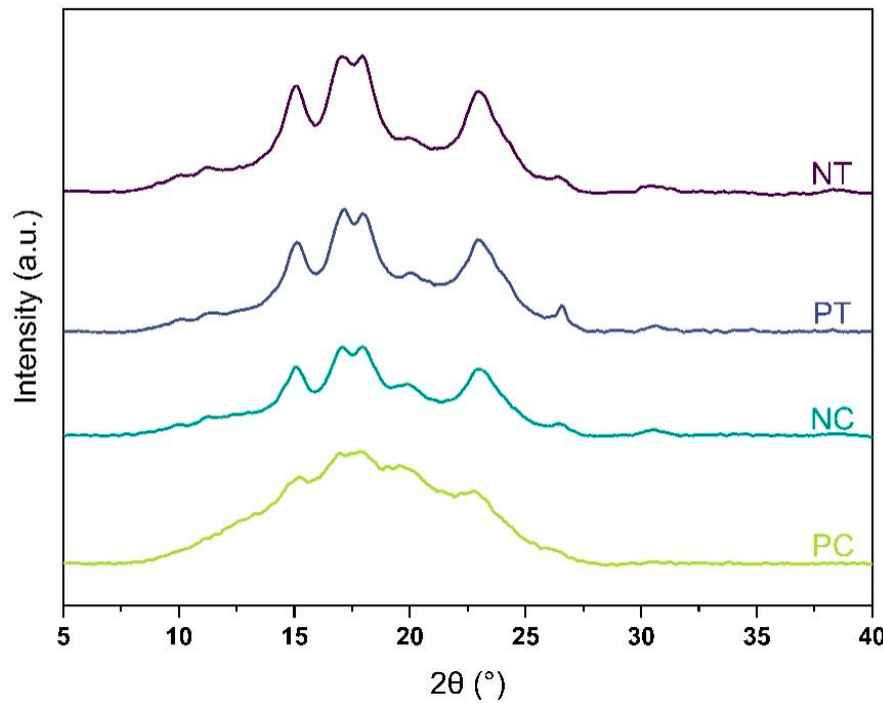
Figure 1. X-ray diffraction patterns of the four starches: NT, native tapioca; PT, pregelatinized tapioca; NC, native corn; PC, pregelatinized corn.